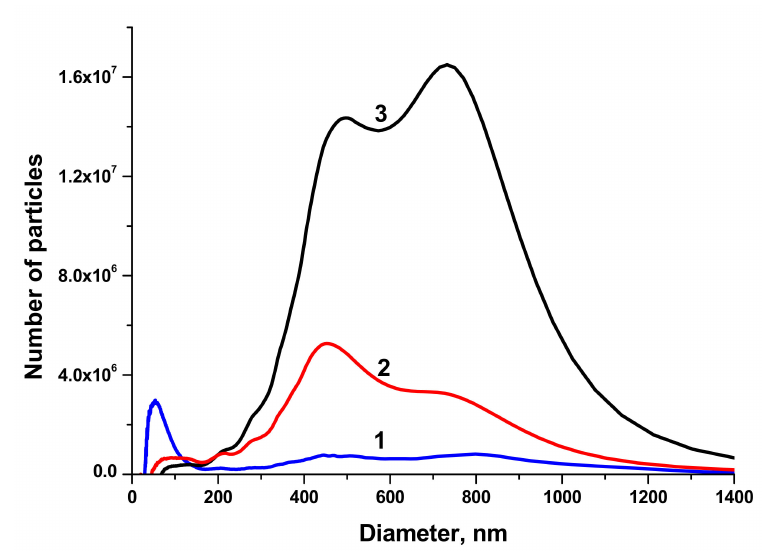
Figure 2. Size distribution of BaTiO 3 NPs generated by laser ablation in H 2 O with pulse duration 200 ns (1), in H 2 O with pulse duration 1 ps (2), in H 2 O 2 with pulse duration 1 ps (3). The volume of the colloidal solution injected into the centrifuge is of 50 µ L.